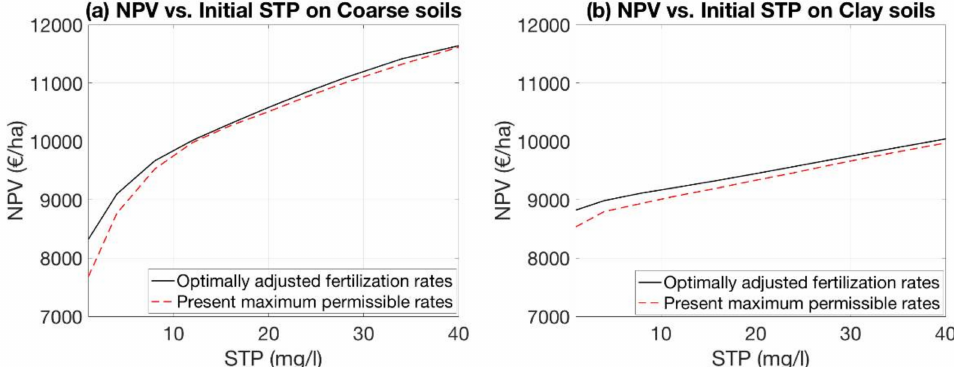
Figure 7. The relationship between the initial soil test P (STP) and net present value (NPV) for the cases where the fertilization paths were determined by economic optimization and by applying the present maximum permissible rates (100 kg N ha − 1 a − 1 ) and declining maximum permissible P rates for the increasing STP